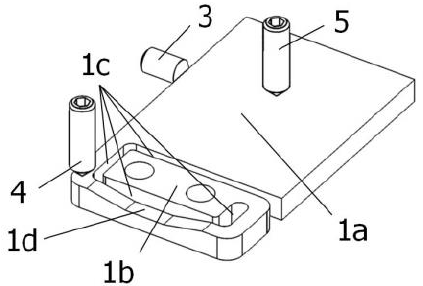
Figure 3. Bottom view of the aligning unit: 1a—supporting section; 1b—mounting section; 1c—U- shaped grove; 1d—relief; 3, 4, 5—aligning screws.